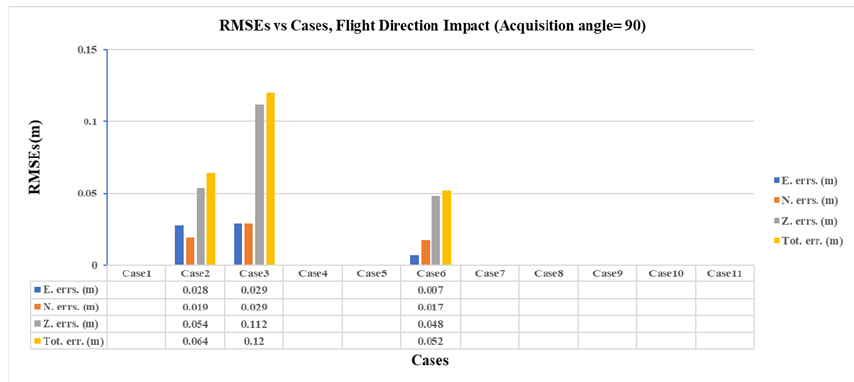
Figure 9. The impact of flight direction (acquisition angle = 90°).